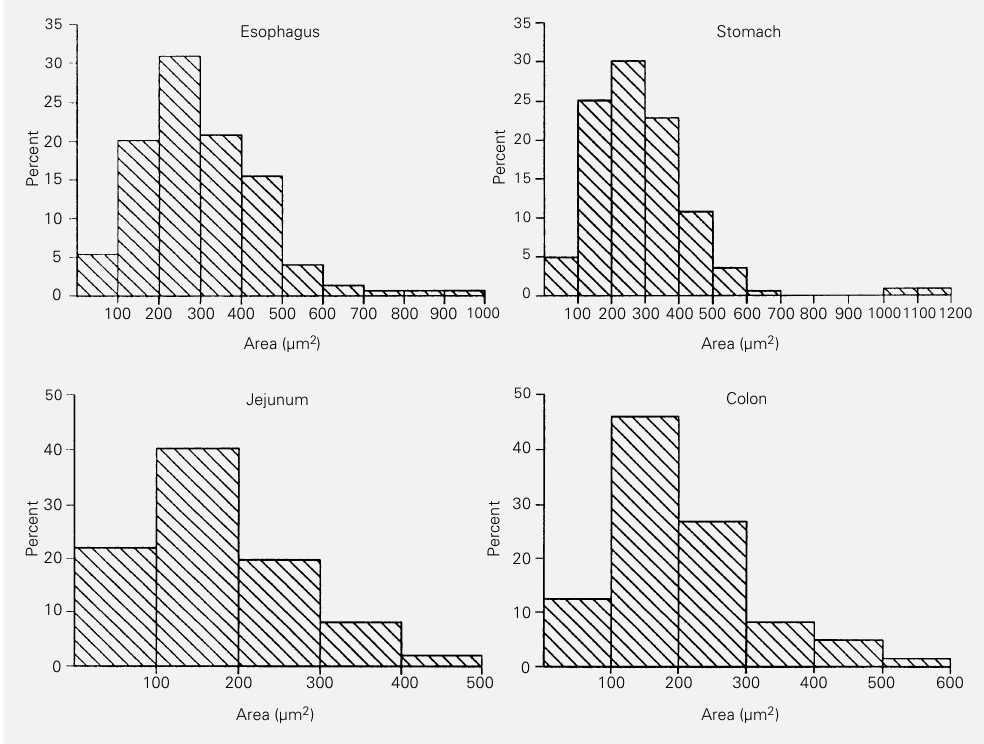
Figure 3 - Distribution of nerve cell profile areas of my- enteric neurons from differ- ent regions of the gut of Calomys callosus . Most neu- rons have nerve cell profile areas of 100 (cid:181)m 2 to 300 (cid:181)m 2 . N = 300 cells measured for each